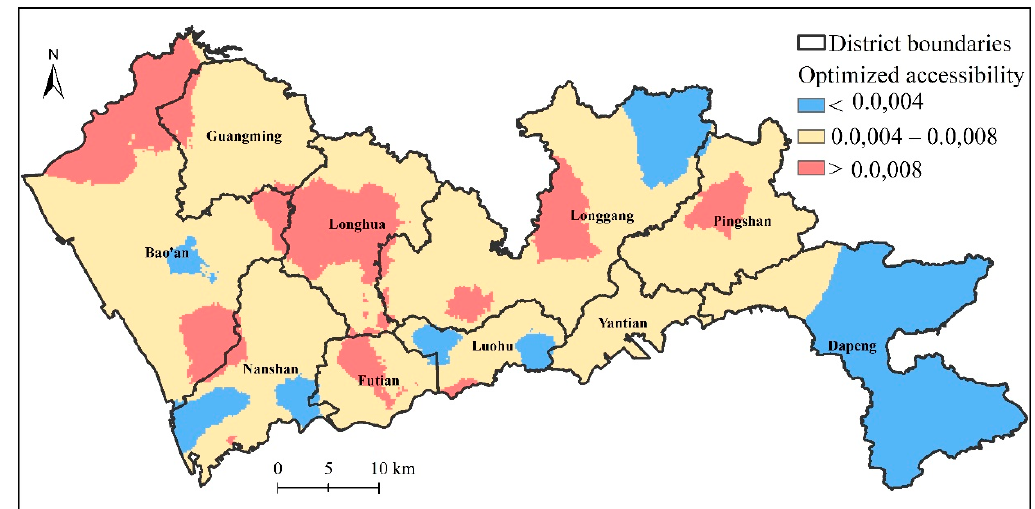
Figure 9. The distribution of optimized accessibility to secondary healthcare facilities.